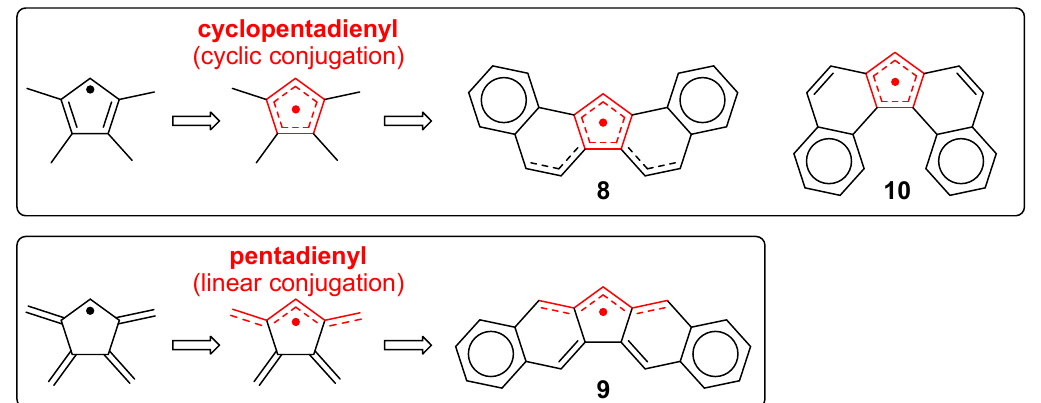
Figure 9. Ring condensation modes for 8 , 9 , and 10 .